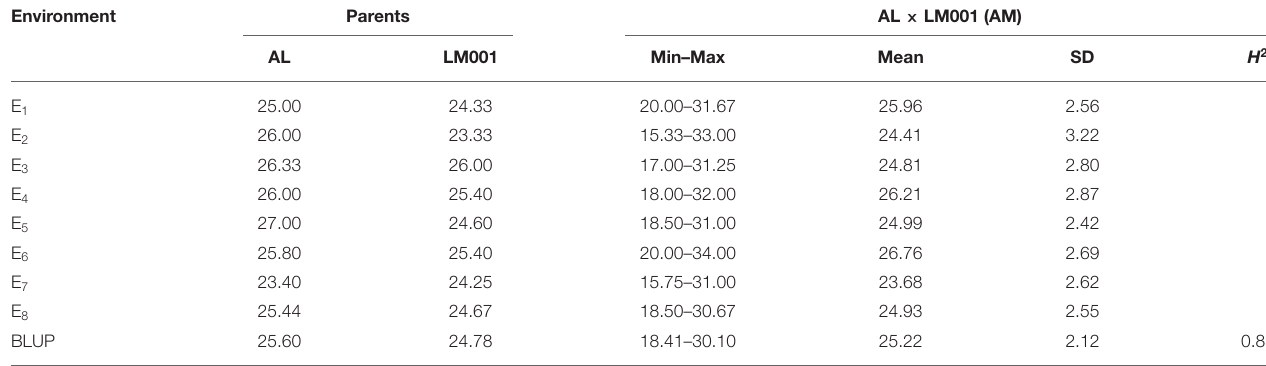
TABLE 2 | Phenotypic data and heritability ( H 2 ) of spikelet number per spike (SNS) for the AM population in multiple environments.